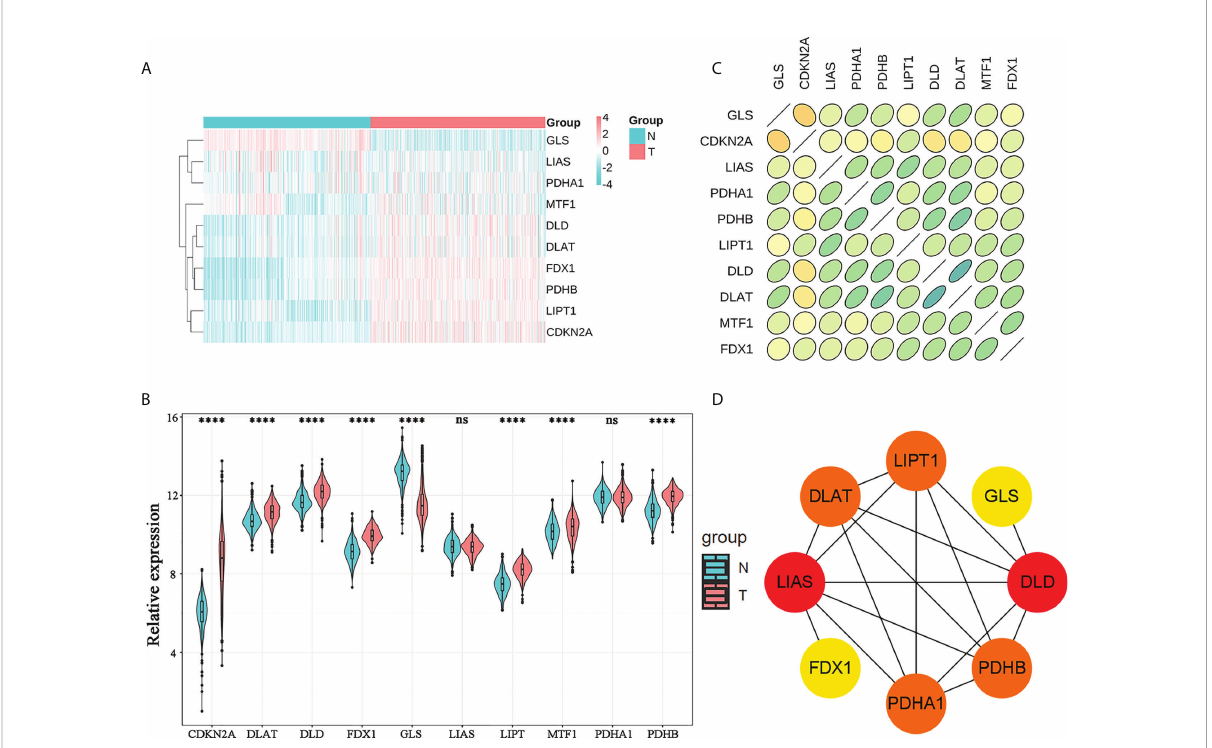
FIGURE 1 Genomic characterization of CRGs. (A) Heatmap of CRG expression in normal brain tissues and WHO 2/3 glioma tissues. (B) Violin plots of CRG expression in normal brain tissues and WHO 2/3 glioma tissues. **** P < 0.0001; ns, not signi fi cant. (C) Correlation plot of CRGs; green represents a positive correlation, yellow represents a negative correlation, and shades of color represent the degree of correlation. (D) PPI network of CRGs in the STRING